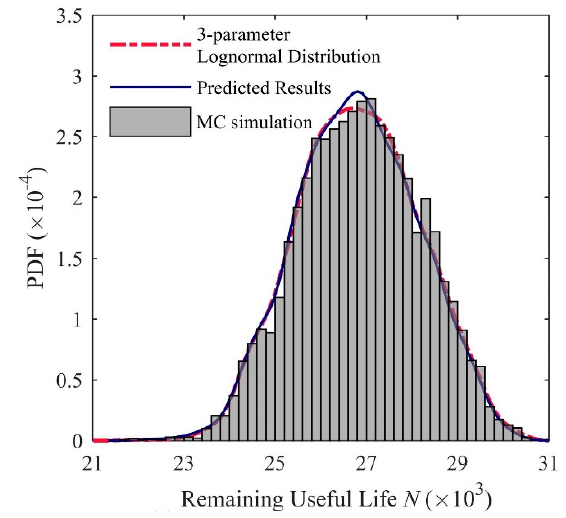
Figure 7. The PDF of remaining useful life.